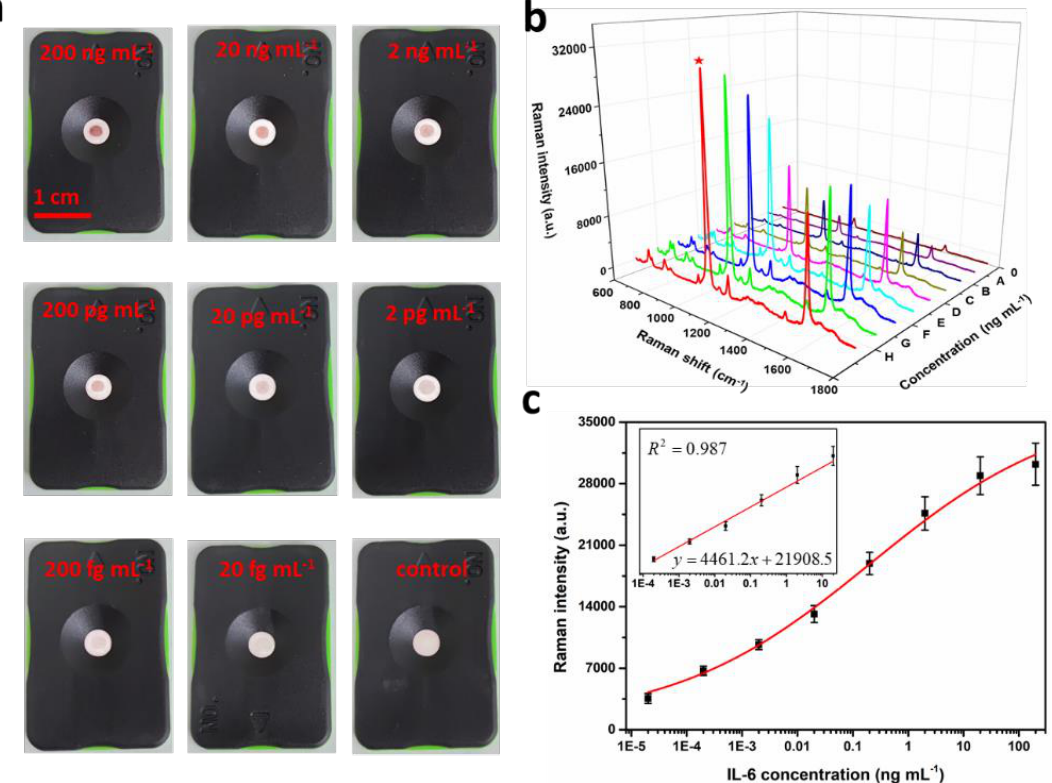
Figure 5. ( a ) Image of the test dot (4 mm in diameter) for different concentrations of IL-6; ( b ) averaged Raman spectra of test dot for different concentrations of IL-6 (A-H corresponding to 20 fg mL − 1 –200 ng mL − 1 ); ( c ) the calibration curve of IL-6, and the inset shown the linear part. The error bars are calculated from three measurements.